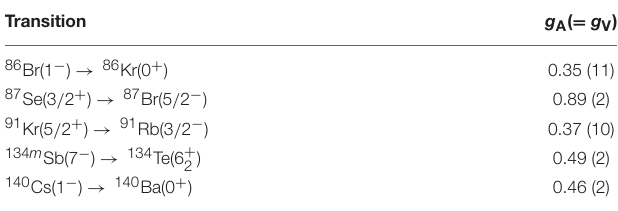
TABLE 5 | Values of the weak couplings g A experimental half-lives of the listed β transitions, mediated by rank-1 tensors (33) of the first-forbidden β